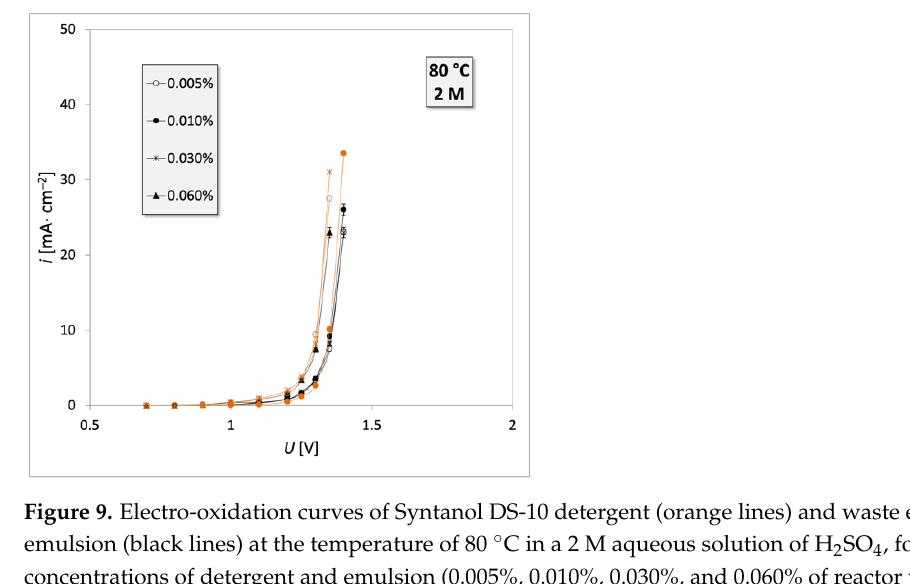
Figure 8. Electro-oxidation curves of Syntanol DS-10 detergent (orange lines) and waste engine oil emulsion (black lines) at the temperature of 60 °C in a 2 M aqueous solution of H 2 SO 4 , for various concentrations of detergent and emulsion (0.005%, 0.010%, 0.030%, and 0.060% of reactor volume).